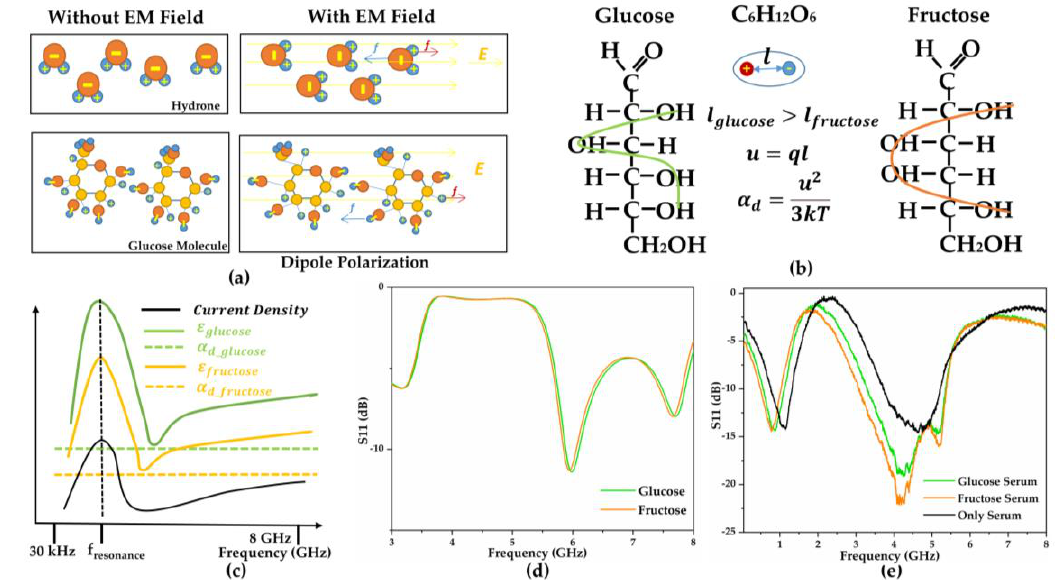
Figure 7. ( a ) Water and glucose molecule dipole polarization with and without the electromagnetic (EM) field. ( b ) Glucose and fructose original structure and polarizability comparison. ( c ) Glucose and fructose polarizability and permittivity response to current density. ( d ) Glucose and fructose simulation response and ( e ) measured results for 100 mg/dL glu-cose/fructose in serum compared to pure